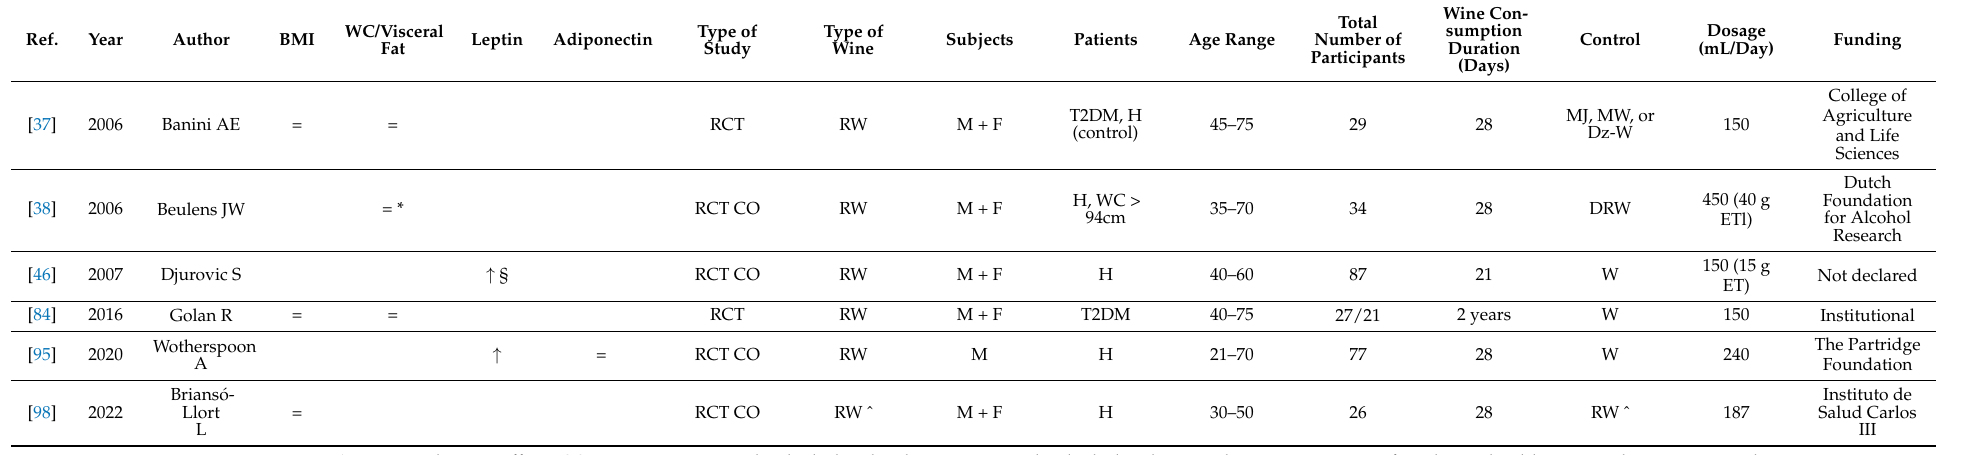
Table 8. Effects of red wine consumption on body weight, obesity, and adipocytokines.